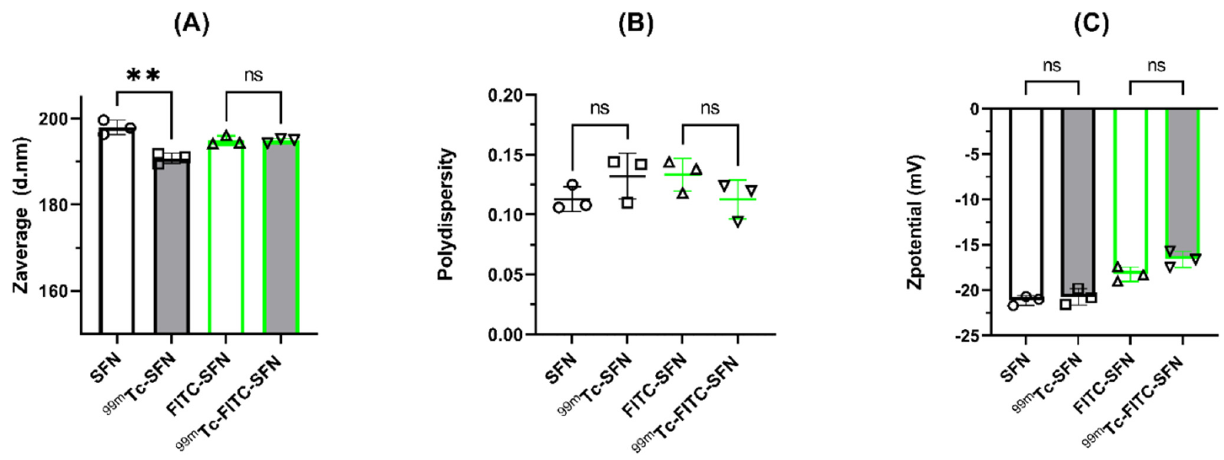
Figure 2. Changes in the hydrodynamic characteristics of the NPs after incubation in blood serum: ( A ) size or Z average (diameter in nm); ( B ) polydispersity; and ( C ) Z potential (mV). The bars or the horizontal lines represent the mean values and the whiskers the standard deviation of the mean. Overlapping symbols indicate individual measured values. Unpaired t-test: **, p < 0.01; n.s., p > 0.05; (n = 3).